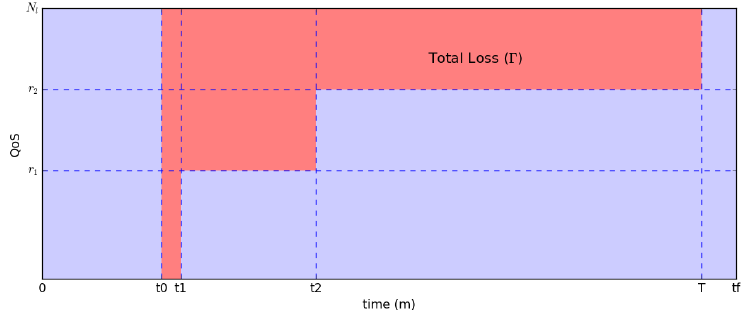
Figure 5. The total loss area with a double failure on an MV